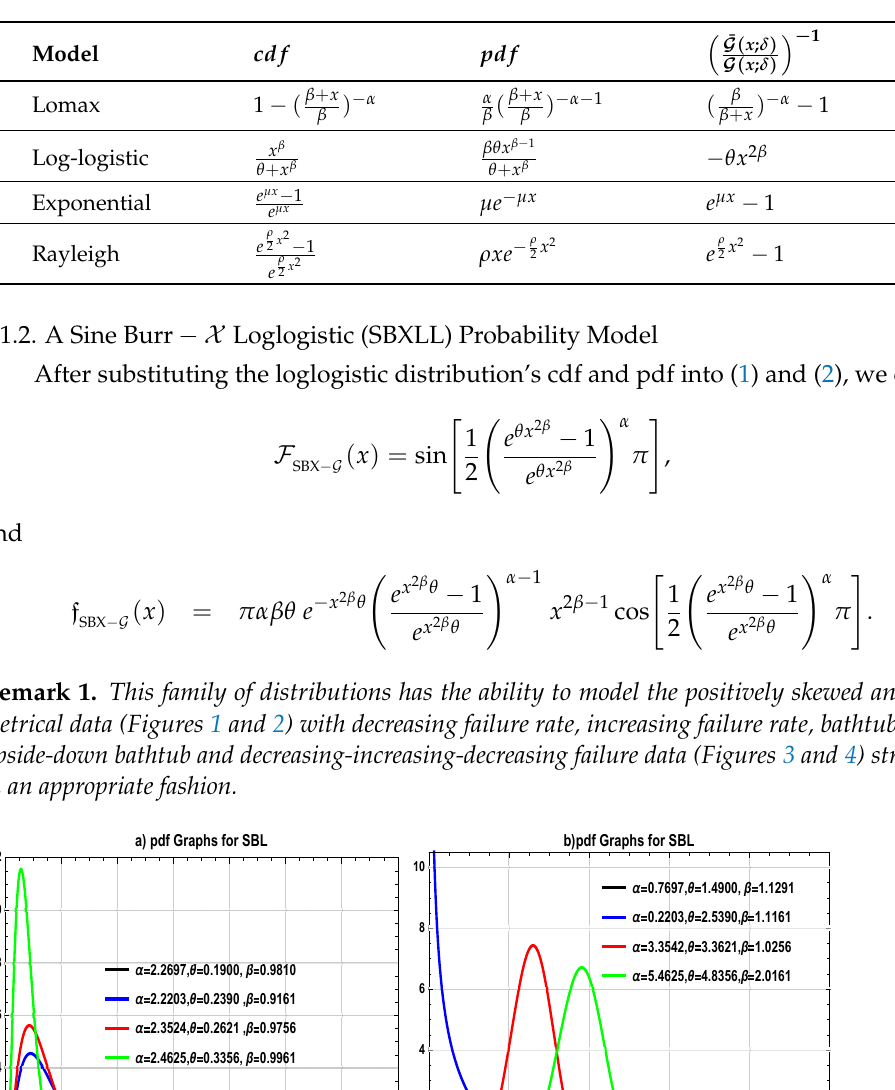
Table 1. Odds ratios and baseline models.